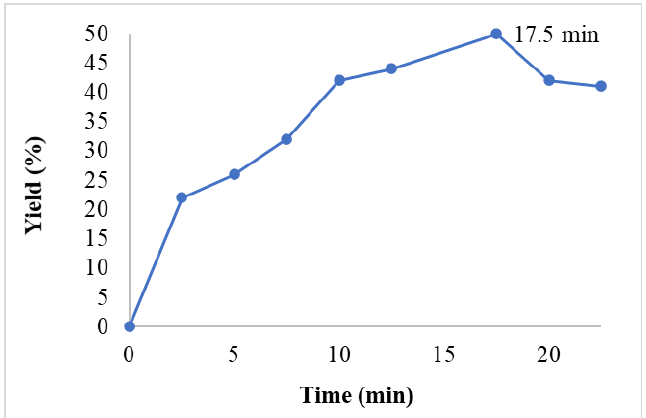
Figure 2. Evaluation of HMF yield over time. Reagents and conditions: 0.25 mmol glucose (45 mg), CX4SO 3 H/NbCl 5 (5/7.5 wt%), MW, 150 °C, water/NaCl, and MIBK (1/3 v / v ).